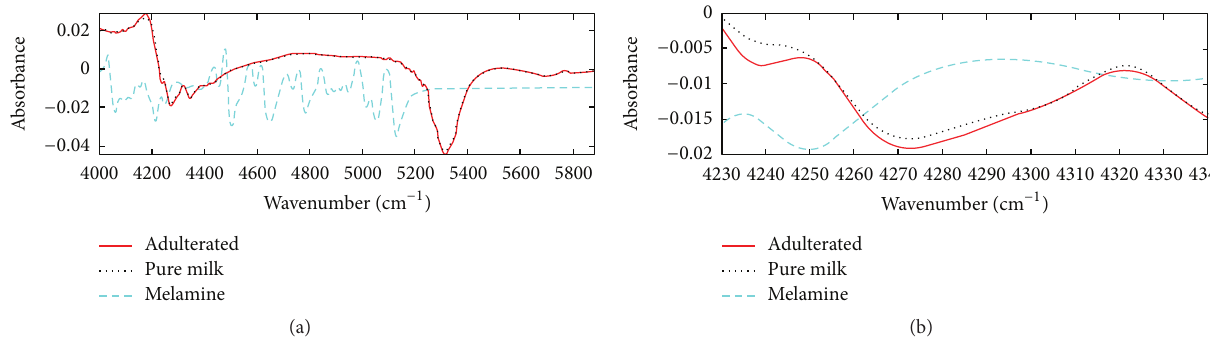
Figure 2: (a) The mean 1st-derivate NIR spectra of adulterated milk, pure milk, and melamine samples in the range of 4000–5880 cm −1 and (b) the enlarged version in the range of 4230–4340 cm −1